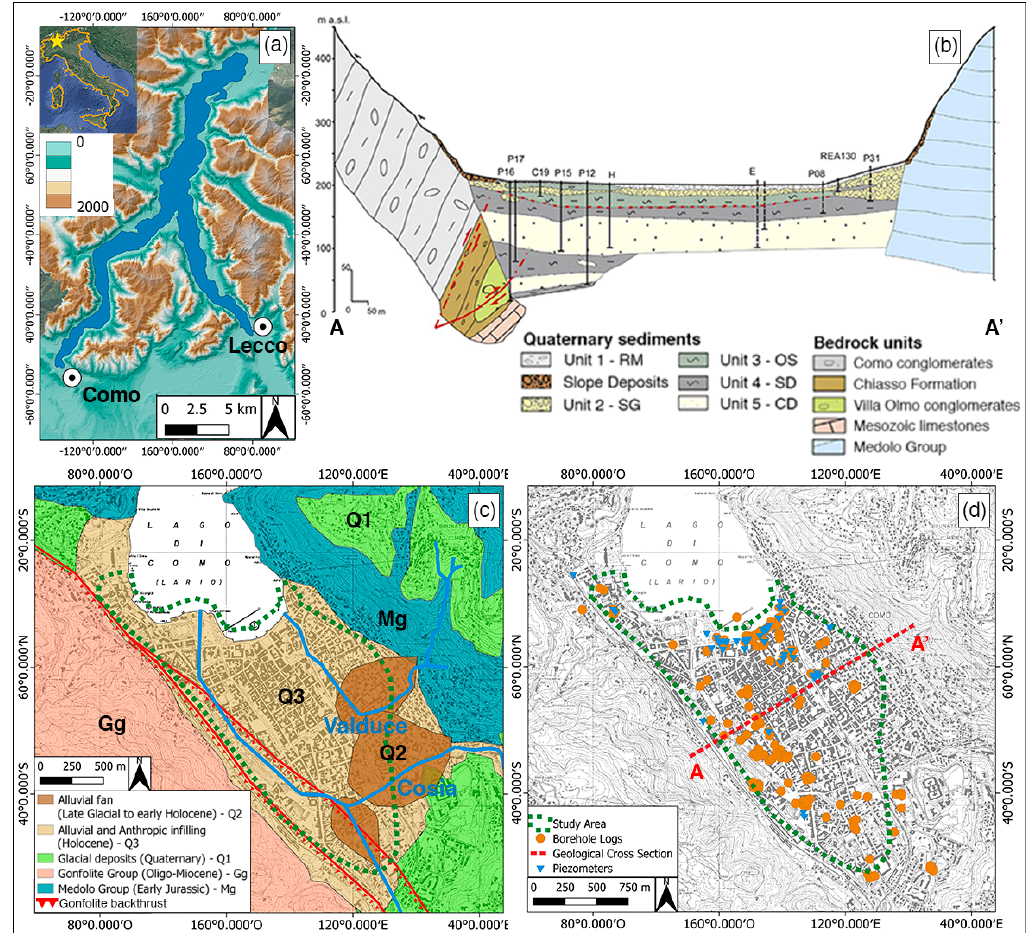
Figure 1. ( a ) Location of Como basin at the southwestern end of the lambda-shaped Lake Como. ( b ) Sketchy geological cross-section of AA’ (note vertical exaggeration); RM stands for reworked material, SG for sands and gravels, OS for organic silts, SD for sediments with dropstones, and CD for coarser deposits (modified from [37]). ( c ) Simplified geological map of the Como basin (modified from [42]). ( d ) Distribution of borehole logs (in orange) and piezometers (in blue), and outline of the geological cross-section.